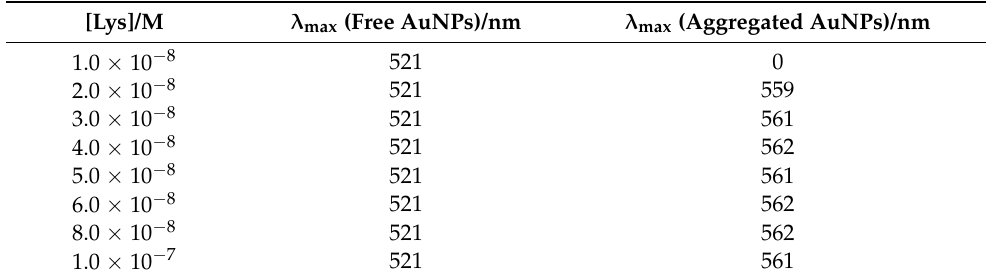
Figure 11. Deconvolution plot for [AuNPs] = 6 × 10 − 8 M. Orange line corresponds to residual Au 3+ salts; red line corresponds to the SPR of free gold nanoparticles and peaks at 522 nm; blue line shows the SPR that arises from the formation of the gold aggregates. Black (dotted) line corresponds to the experimental spectra and green (dashed) line corresponds to the sum of all deconvoluted bands. Table 4. Values of λ max /nm for both free and aggregated AuNPs at different protein concentrations.